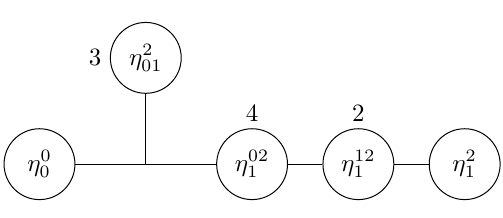
\ T \ V ( f ), Resolution II. 2 -model at S